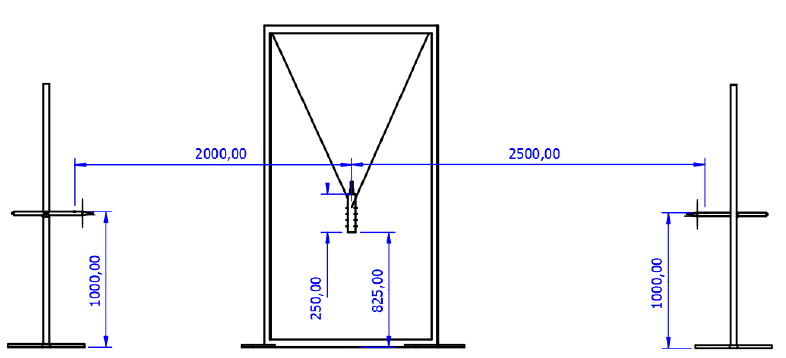
Figure 1. Experimental setup for the determination of shock wave parameters and detonation